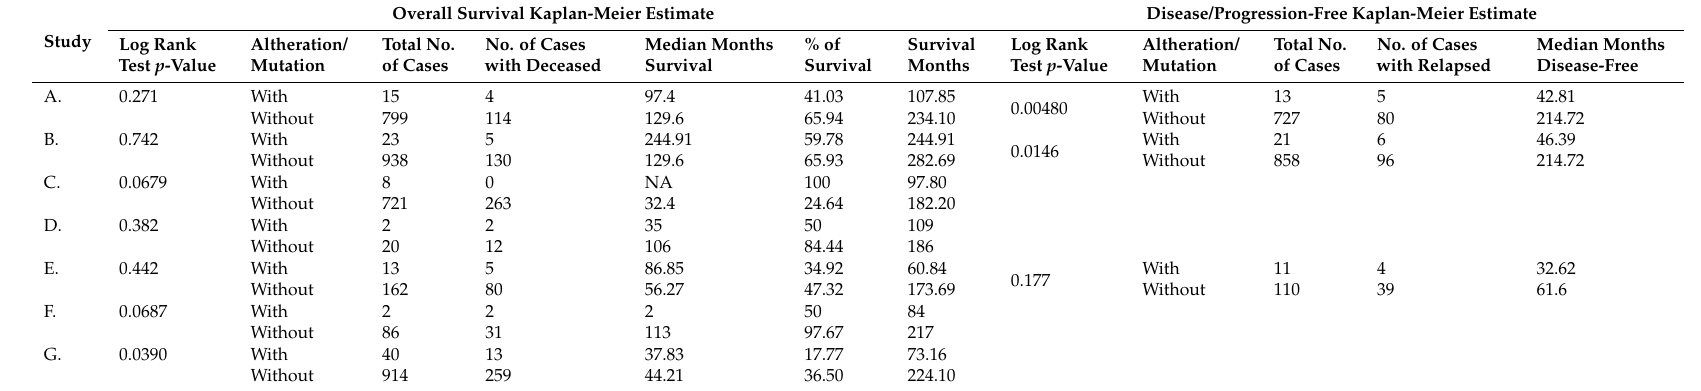
Table 3. Gene alteration of SERTAD1 regulates prognostic value of patient’s